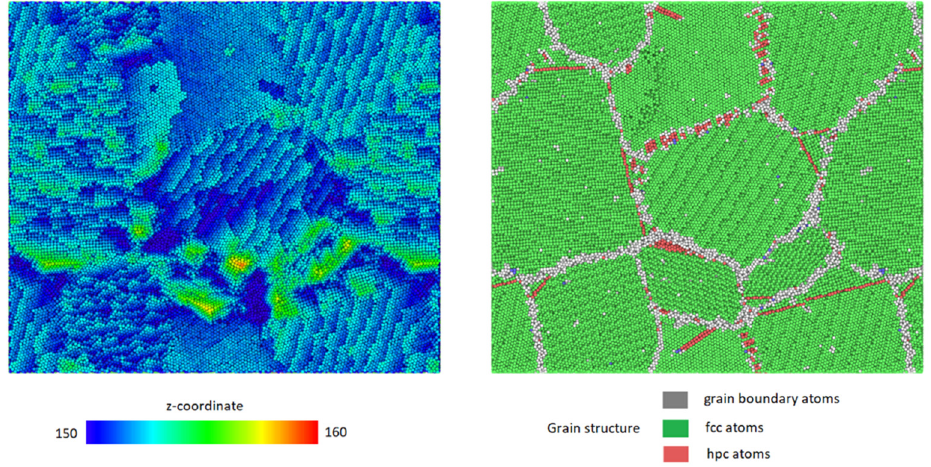
Figure 6. Height mapping ( left ) and the underlying grain structure ( right ) of the system subject to constant tensile stress. A clear tendency of self-roughening is seen under the constant stress, which is lower than critical one in the left image.